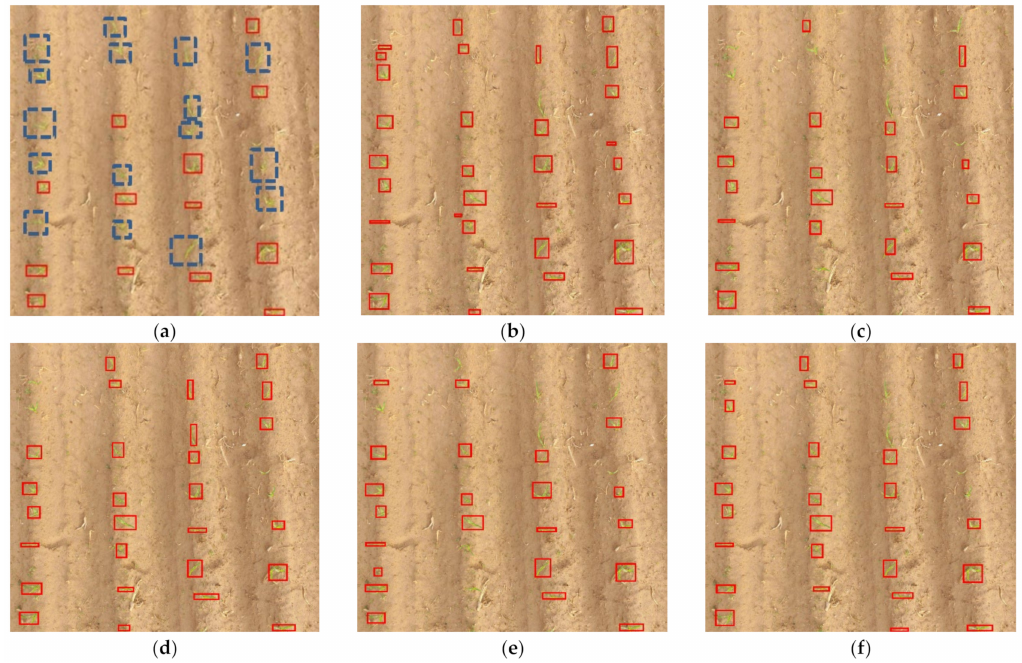
Figure 10. Detection results of different models: ( a ) YOLOv4 test results; ( b ) Improved YOLOv4 lightweight networks test results; ( c ) Mbilenetv1-YOLOv4 test results; ( d ) Mobilenetv3-YOLOv4 test results; ( e ) Densenet121-YOLOv4 test results; ( f ) Vgg-YOLOv4 test